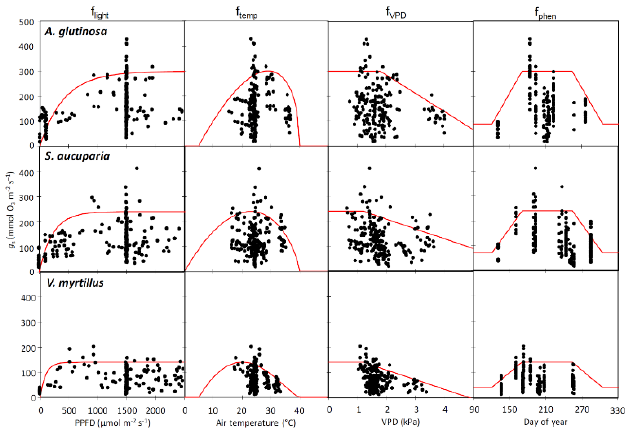
Figure 5. Parameterization of f light , f temp , f VPD , and f phen in stomatal conductance model for Alnus glutinosa , Sorbus aucuparia, and Vaccinium myrtillus exposed to three levels of O 3 concentration (AA, ambient O 3 concentration 1.5 × AA, and 2.0 × AA). Red lines show model functions and black points show measured stomatal conductance.